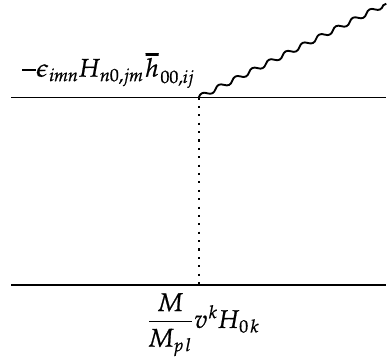
Figure 8 . Leading order EB-Mass